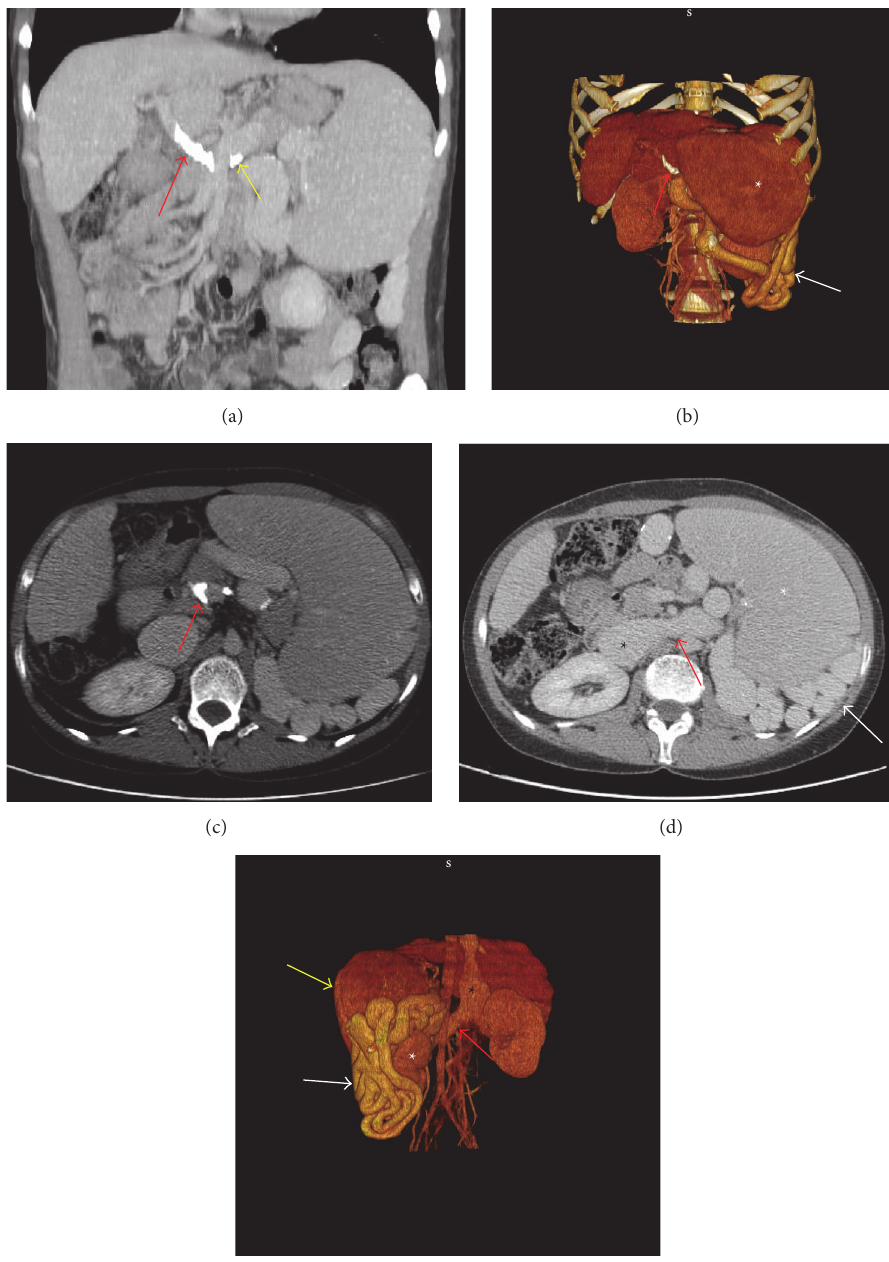
Figure 1: (a) MIP sagittal reconstruction showing portal vein calcified thrombosis. The thrombus appears as hyperdense structure occluding the portal vein lumen (red arrow). A little thrombus in the Splenic Vein is also evident (yellow arrow). (b) VR reformation showing portal vein calcified thrombosis (red arrow). The thrombus appears as hyperdense structure occluding the portal vein lumen (red arrow). Spleen (white star) and Splenorenal Shunt (white arrow) are also evident. (c) Axial view (portal phase) showing calcified thrombi partially occluding the superior mesenteric vein lumen (red arrow). (d) Axial view (portal phase) showing the Splenorenal Shunt (white arrow) behind the spleen (white star). Renal vein (red arrow) and Inferior Vena Cava (black star) dilatation is also evident. (e) VR reformation showing the Splenorenal Shunt (white arrow) among the spleen (yellow arrow) and the left kidney (white star). Renal vein (red arrow) and Inferior Vena Cava (black star) dilatation is also